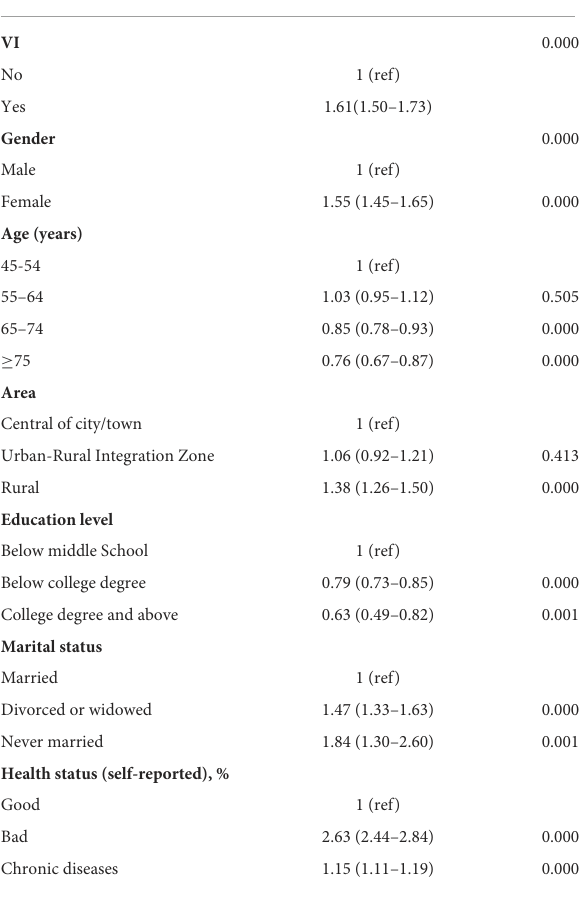
TABLE 2 Association of VI and depression: Logistic regression results.